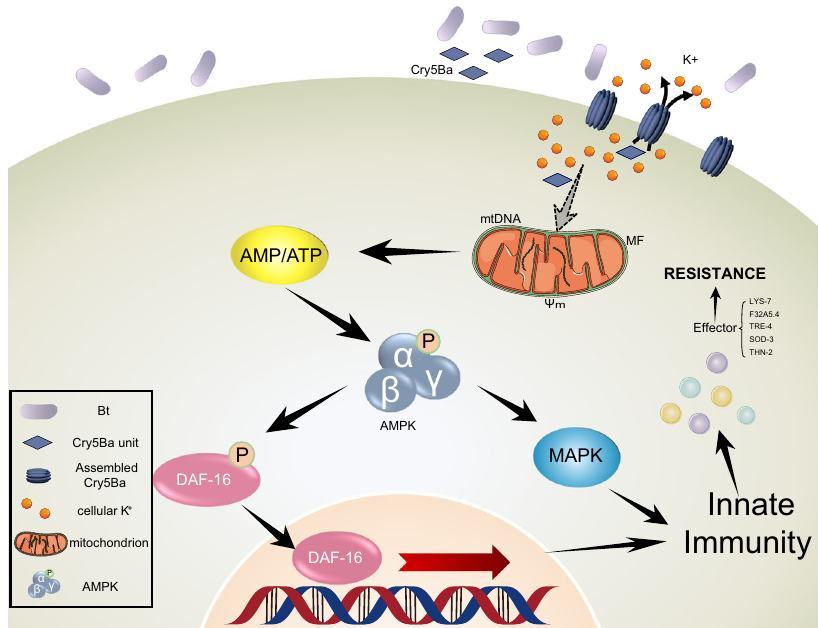
Fig. 8 The action model of mitochondria surveillance systems for recognition of pathogens and the activation innate immune responses by AMPK in C. elegans . After nematicidal Bt and crystals mixture are fed to the C. elegans , the Cry5Ba toxin is transported into the intestinal epithelial cell plasma membrane and assembled to trigger pore formation, resulting in the potassium ion leakage. The potassium ion leakage caused by Cry5Ba disrupts mitochondria, which indirectly leads to MF, a decrease in mitochondrial membrane potential, and the changes in mtDNA content, ultimately resulting in cellular energy imbalance. AMPK senses Bt-induced intercellular AMP/ATP changes and then phosphorylates AAK-2. The activated AAK-2 modulates DAF-16 and p38-MAPK-dependent innate immune pathways to defend against pathogens. Solid arrows represent relationships con fi rmed in this study. The dotted arrow represents an indirect TGGAACTCTGGAGTCACACC, Reverse: CATCCTCCTTCATTGAACGG). Synchronized worms were treated and collected as described above. Collecting